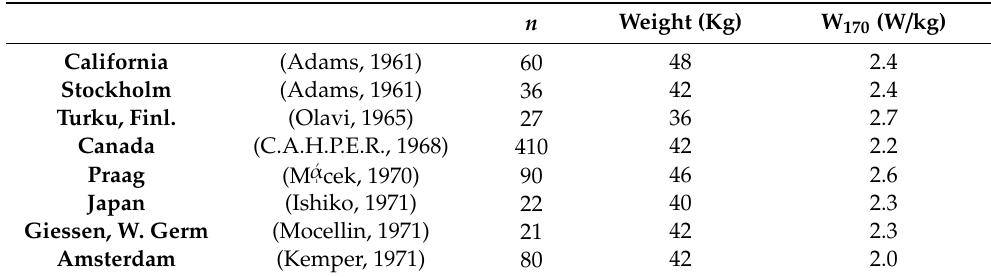
Table 1. Comparison of PWC 170 values (= W 170 ( W/kg)) of the 13-year-old boys with boys of the same age in seven other countries [2].